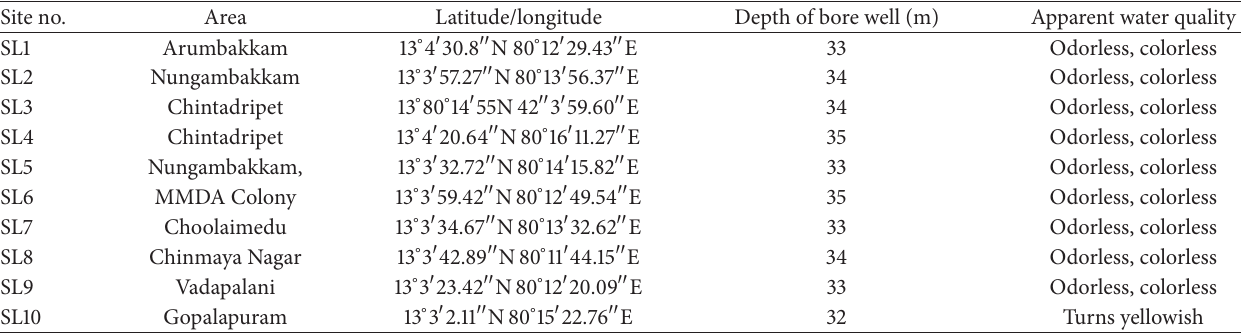
Table 1: Detail of sample sites along the left side (SL) of the Cooum river.